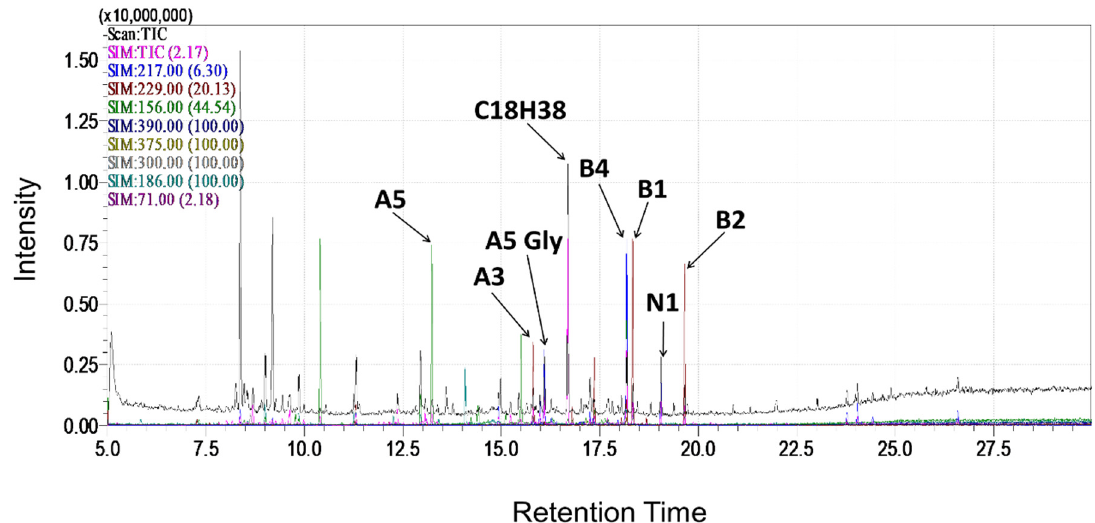
Figure 1. GC-MS chromatogram of Hyoscyamus albus seeds calystegines. Ions were monitorised in SIM. A total of 217 m / z was used as a common ion for calystegines B2, B3 and B4; 229 m / z for calystegine B2; 244 m / z for calystegine B4; 189 m / z for calystegine B1, 156 m / z for calystegines A3 and A5; 390 m / z for calystegine N1. Octadecan (C18H38, 71 m / z ) was used as an internal standard [24].